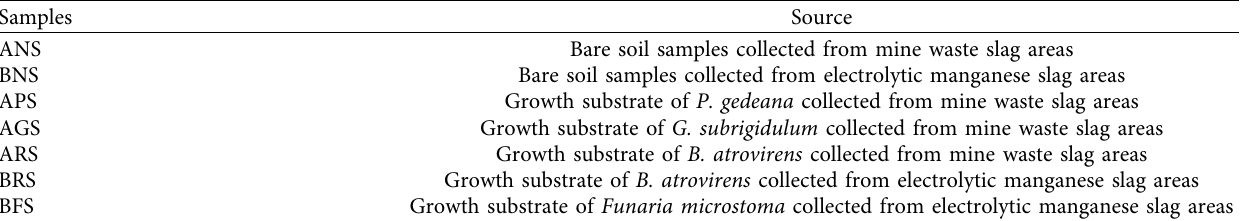
Table 2: Samples of microbial diversity